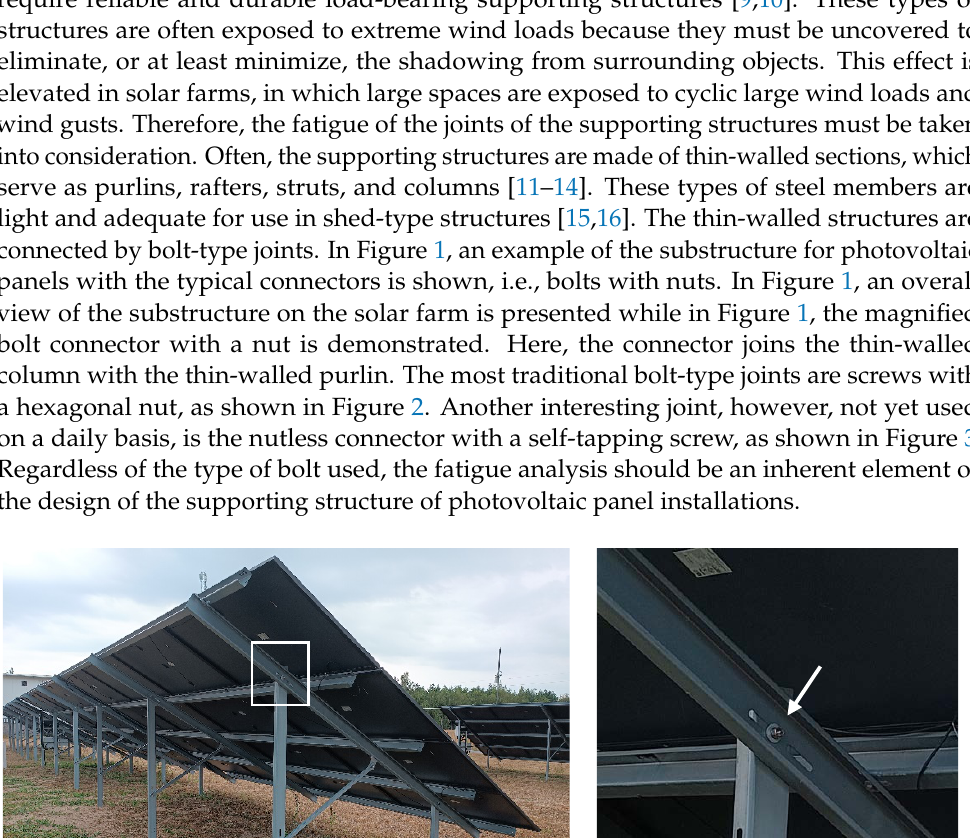
Figure 2. Pictures of the M12 bolt with hexagonal nut connectors: ( a ) view of the nut from the bottom of the joint and ( b ) side view (source: grant POIR.01.01.01-00-0177/21).